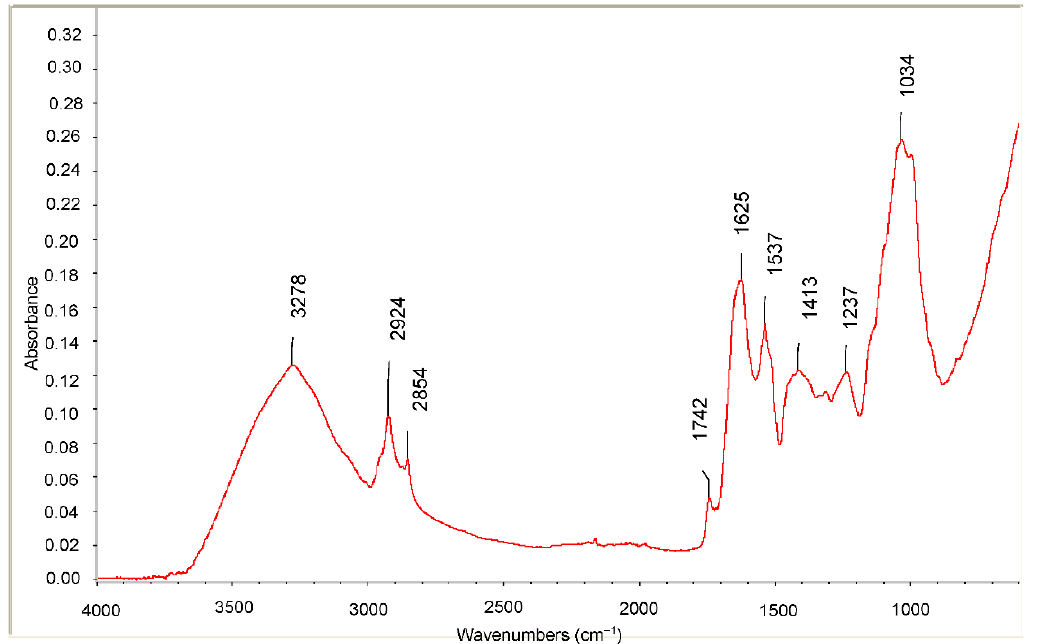
Figure 1. The averaged spectra from the rapeseed meal samples.